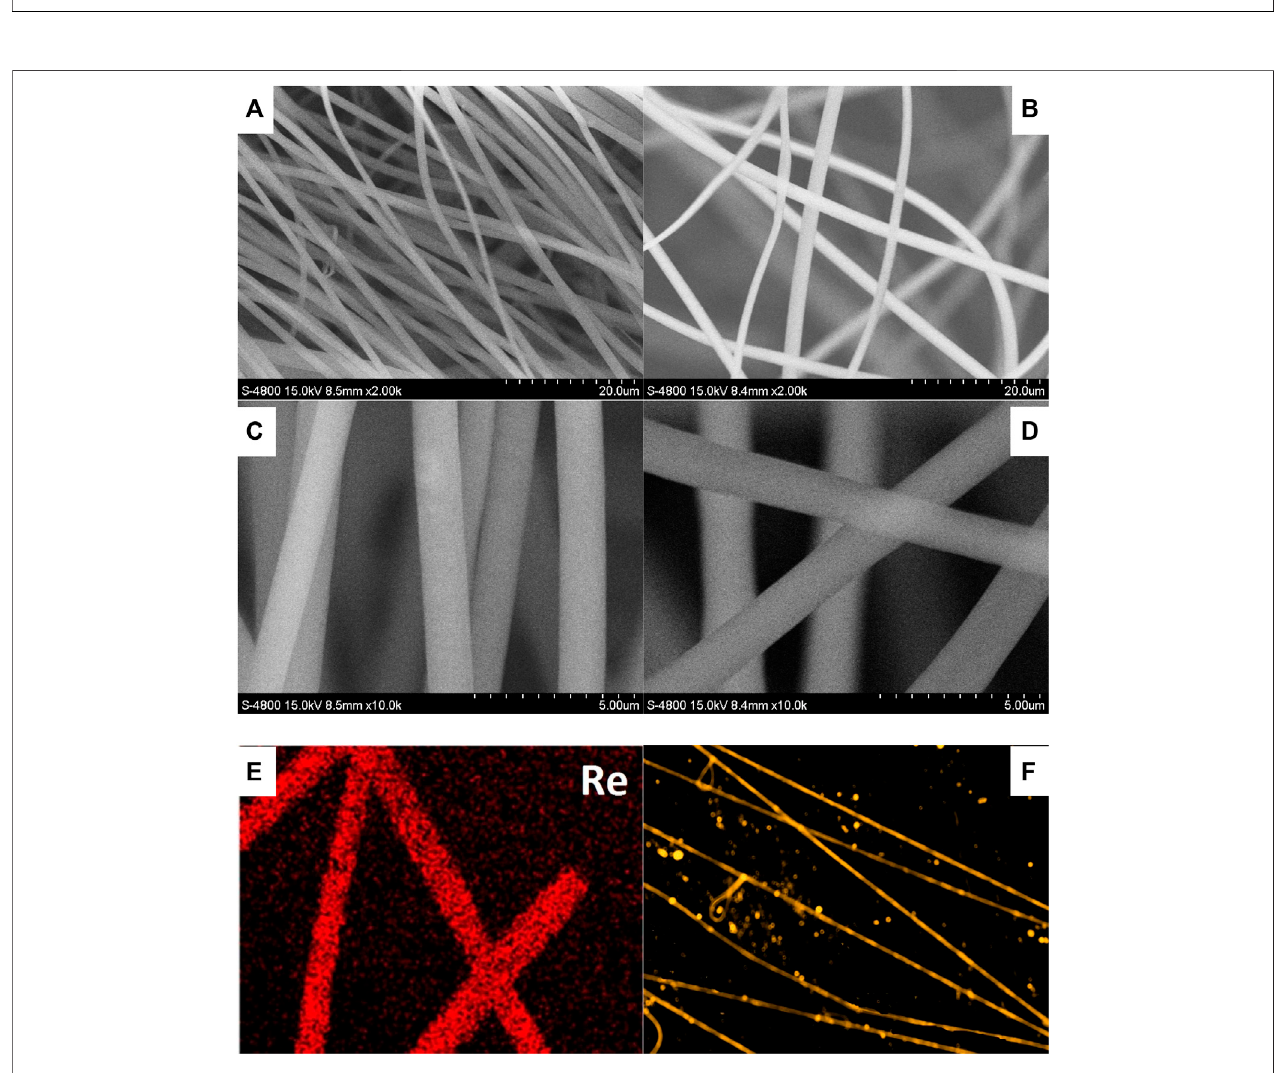
Frontiers in Chemistry |